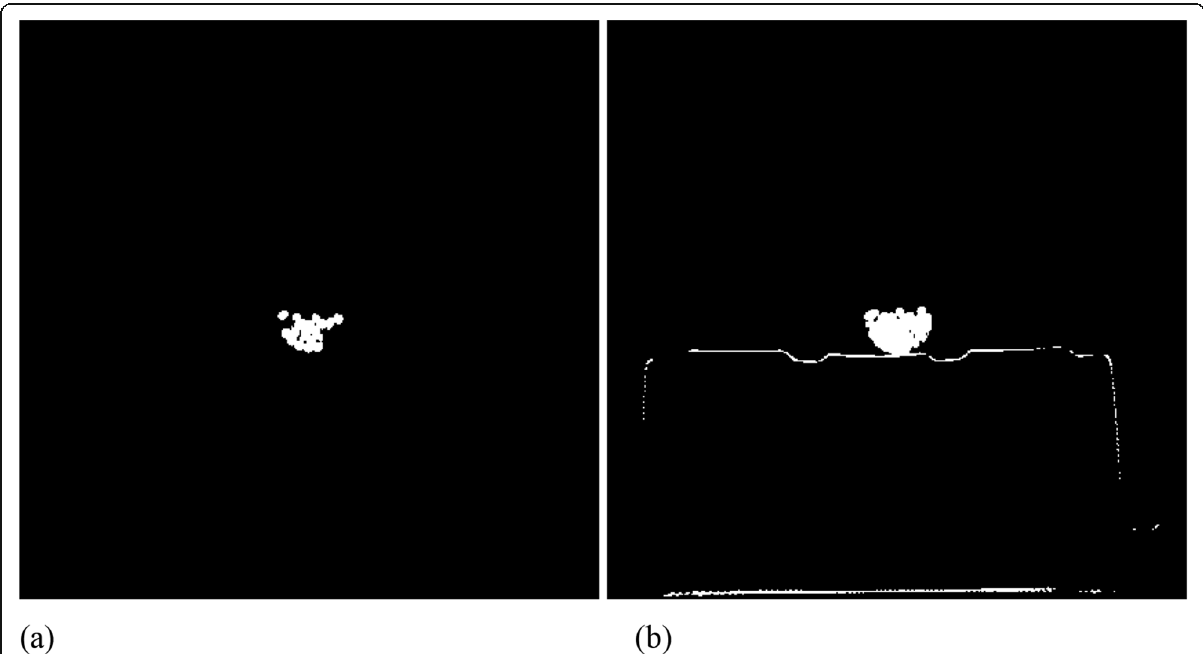
Fig. 7 Metal images for bag #5. a The segmentation threshold t = 1/3 of the maximum raw FBP image pixel value; b The segmentation threshold t = 1/10 of the maximum raw FBP image pixel value